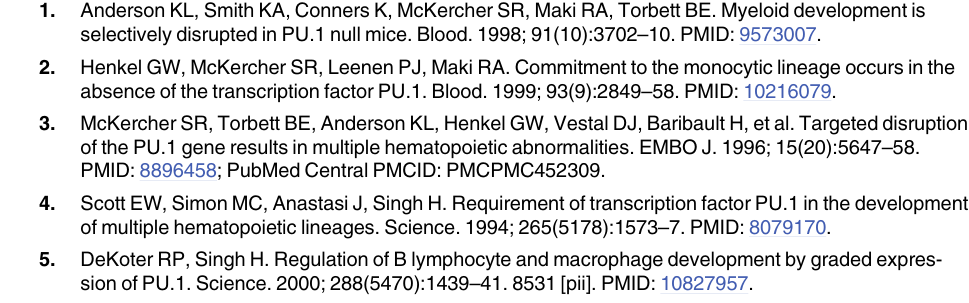
S1 Table. Nucleotide sequences of primers used in ChIP